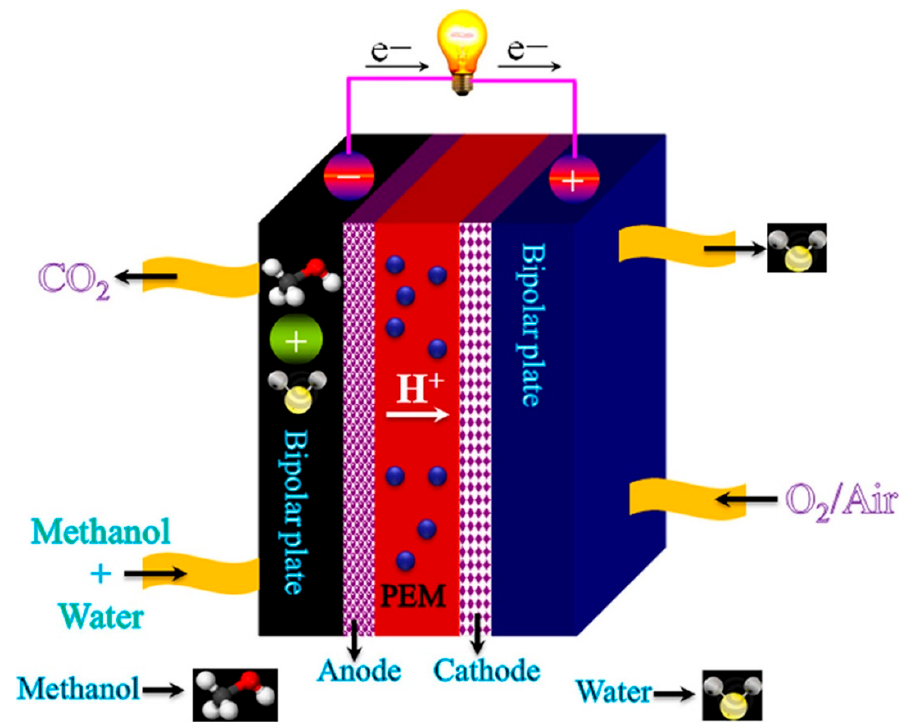
Figure 12. Schematic diagram of a DMFC with PEM polymer electrolyte membrane [143].